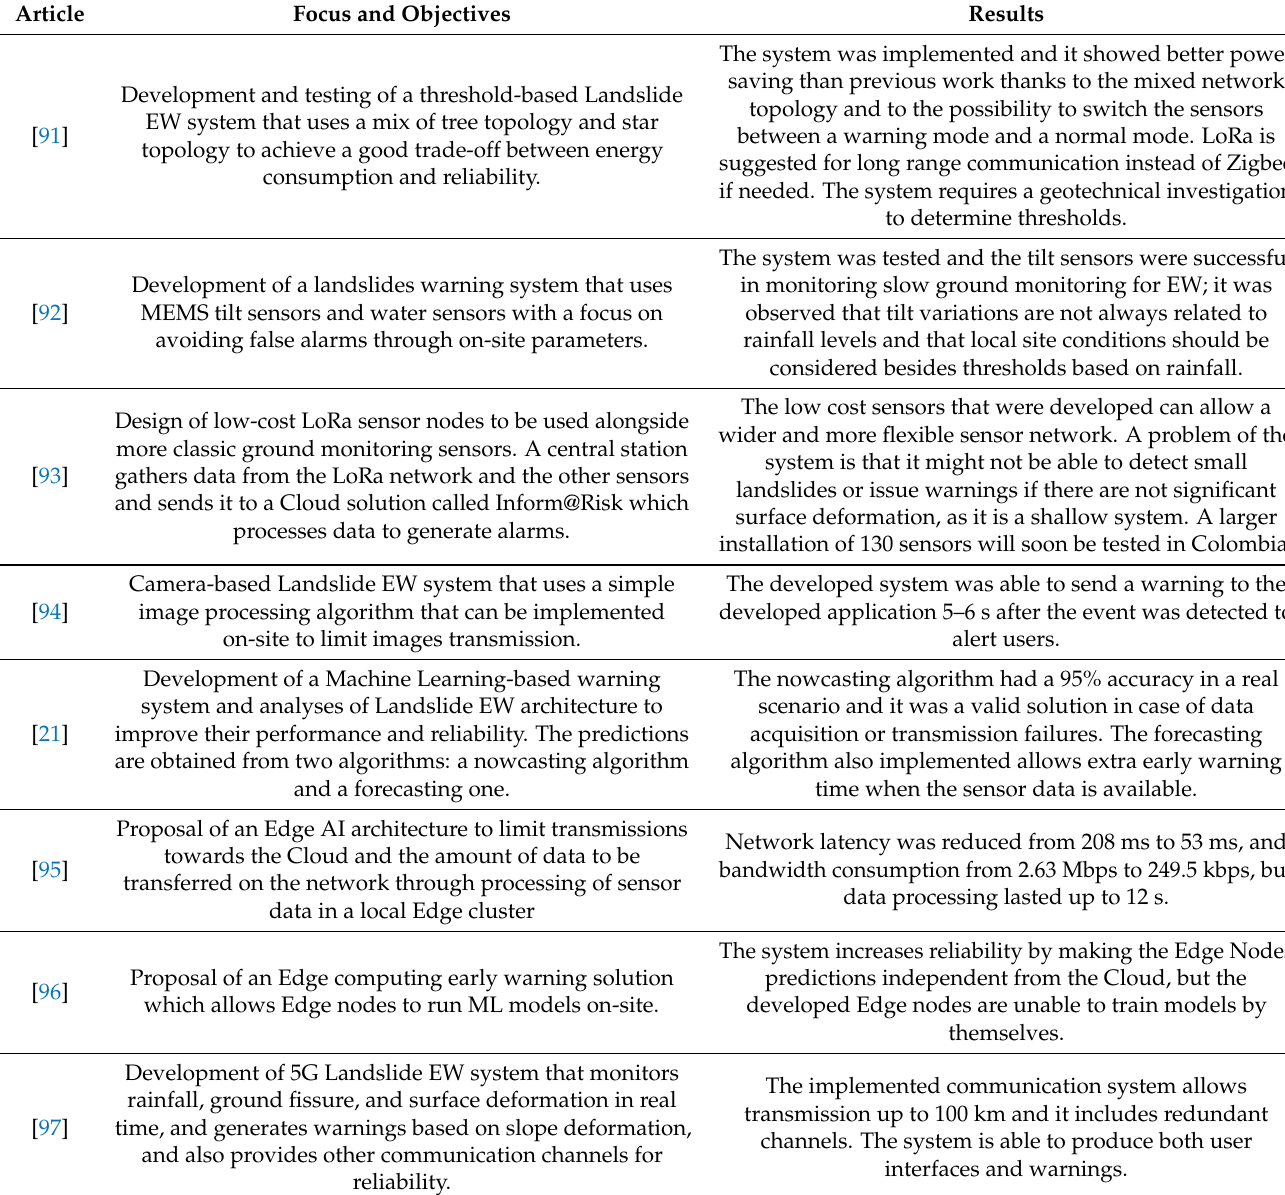
Table 7. Reviewed Articles in Landslide